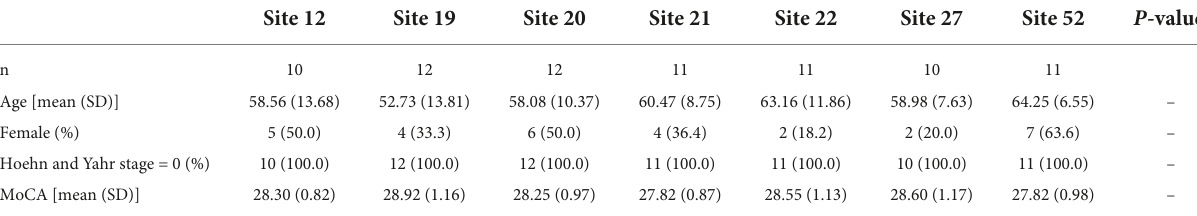
TABLE 1 Demographic and clinical details of healthy controls for each site.